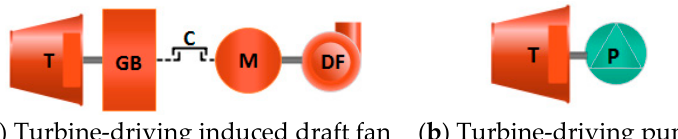
Figure 2. Configuration of the turbine-driving induced draft fan and pumps. Key : GB-gear box; C-coupling; M-motor; P-pump.